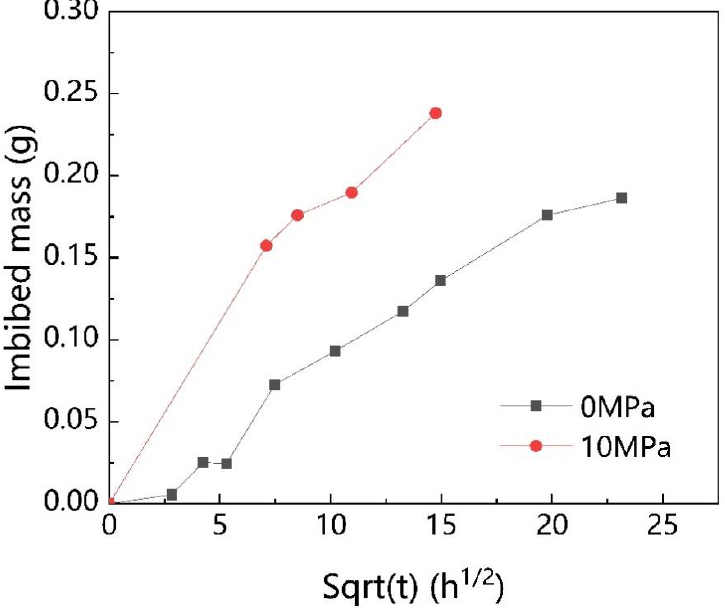
Figure 9. Comparison of imbibition development of sample XEW under 1 atm and 10 MPa, respec- tively.